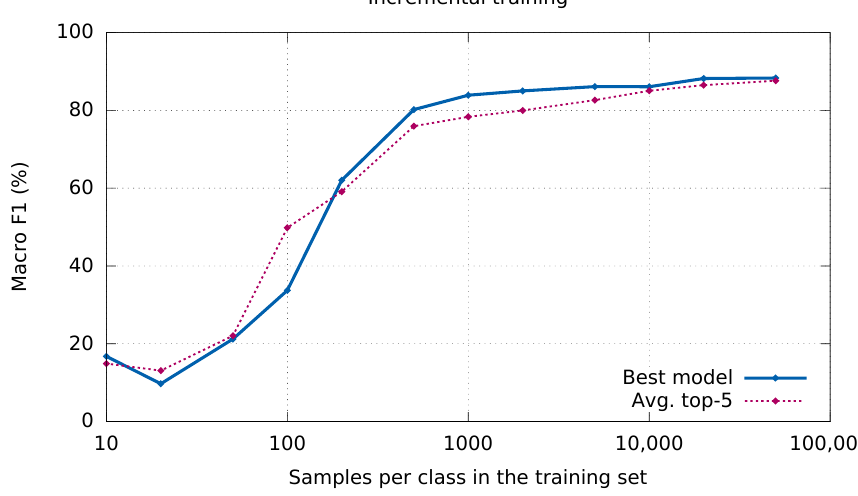
Figure 9. Evolution of the learning process (in terms of F M ) with respect to the size of the training set, 1 measured as the number of samples per class. The plain blue curve shows the evolution of the best model considered in our experiments, while the dashed red one is the average of the five best models. Note that the x -axis presents a logarithmic